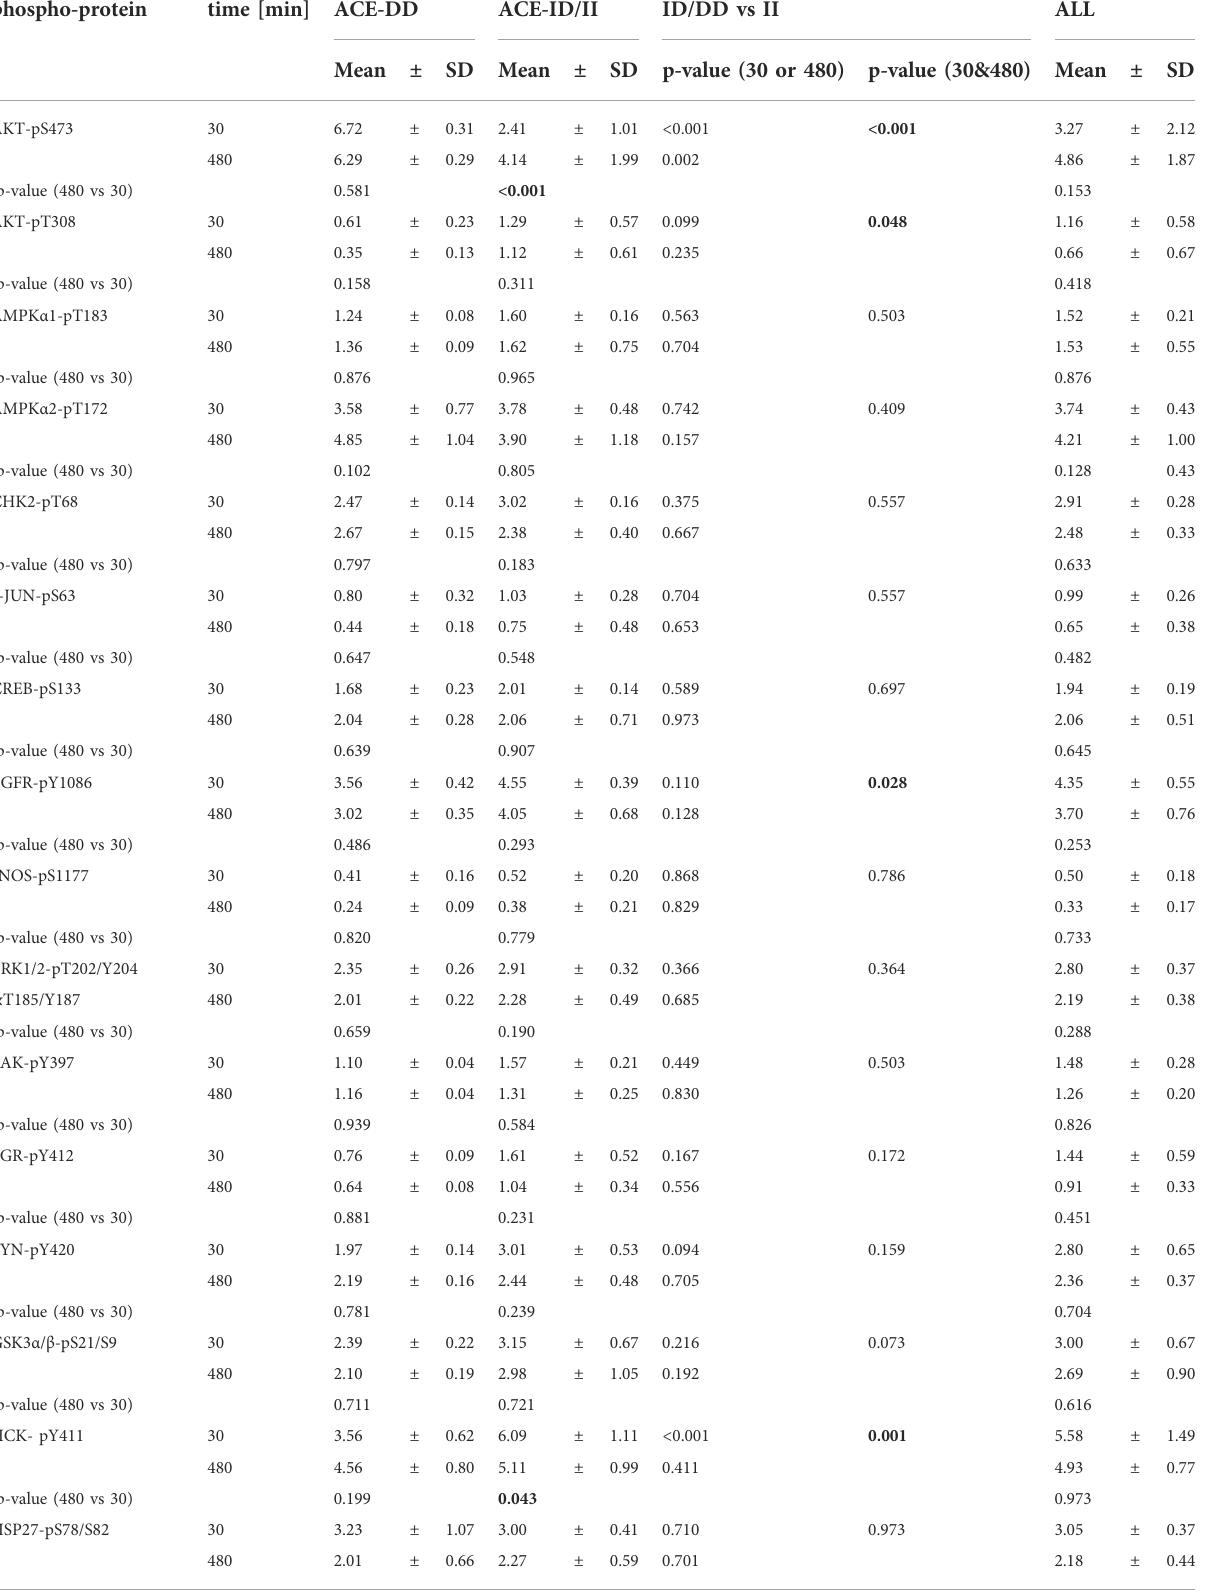
TABLE 4 Exercise-induced alterations of the muscle kinome in dependence of the ACE-I/D genotype. phospho-protein